Question: Condense the content of this figure into a single sentence.
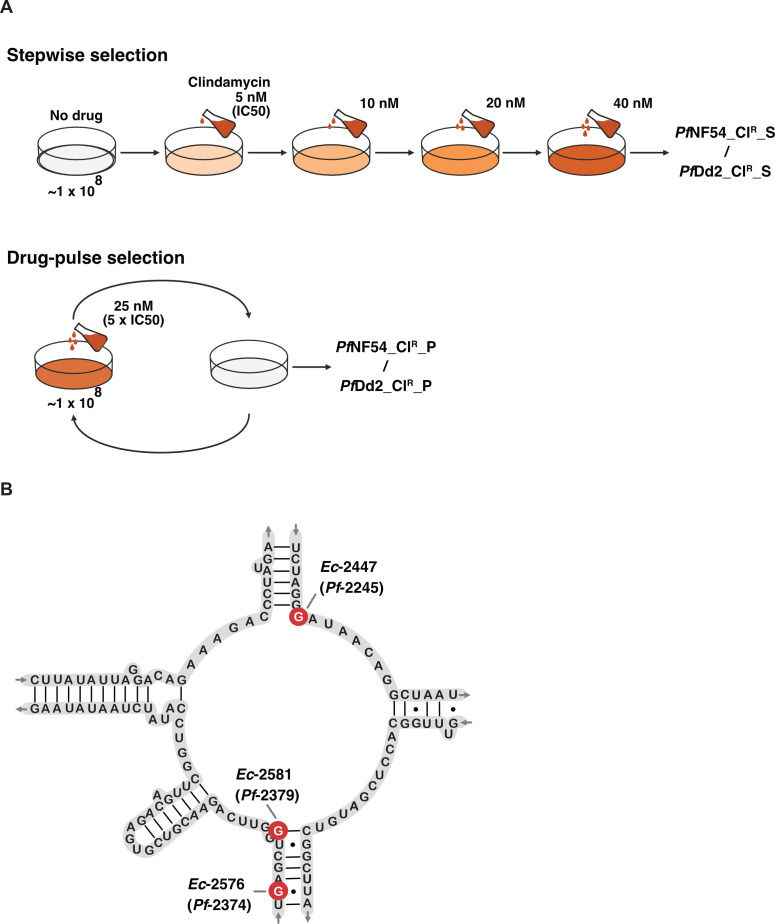
Answer: Generation and identification of clindamycin-resistant 23S ribosomal RNA P. falciparum parasites. ( A ) Graphic of the selection regime methodology to generate Pf NF54_Cl R _S and Pf Dd2_Cl R _S by stepwise selection and Pf NF54_Cl R _P and Pf Dd2_Cl R _P by pulse selection. ( B ) Predicted secondary structure of P. falciparum peptidyl transferase center (PTC) of the apicoplast 23S ribosomal RNA as previously published ( 18 ). Residues highlighted in red indicate location of mutations identified in NF54 and Dd2 selected clindamycin-resistant P. falciparum .